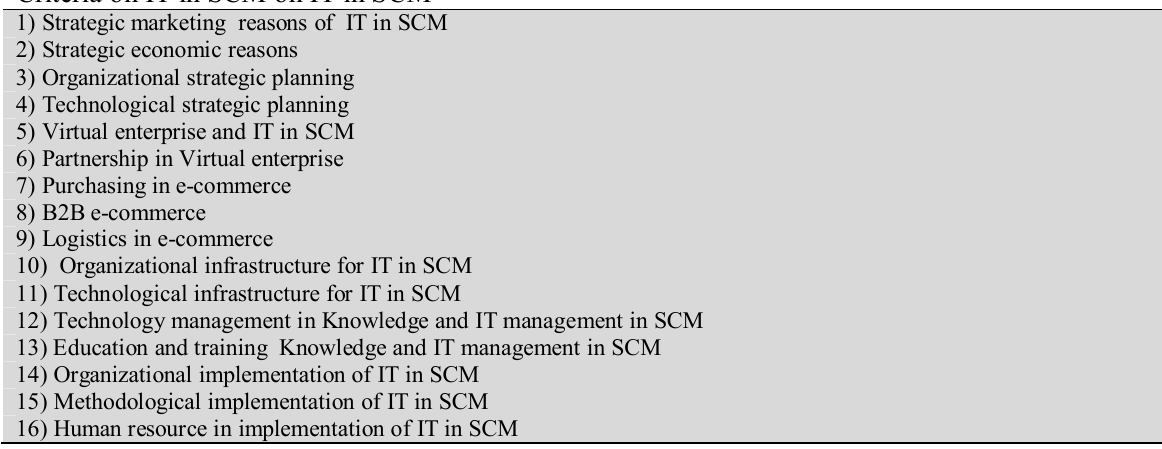
Total variance explained using PCA ( Extraction method: principal component analysis ) Initial eigenvalues Component